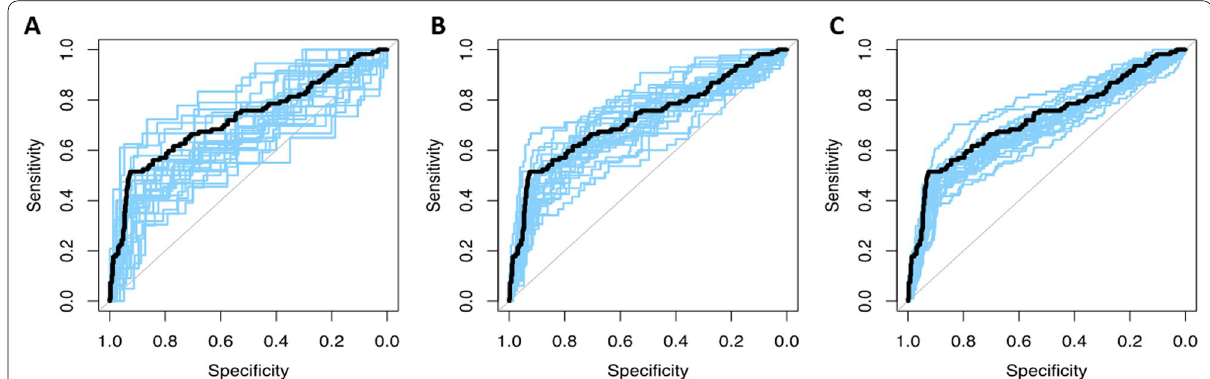
Fig. 1 AUCs of 25 repeats of external simulated datasets with different sizes in blue with the simulated true expected AUC in black A an simulated external dataset of 100 patients, B simulated external dataset of 200 patients and C simulated external dataset of 500 patients